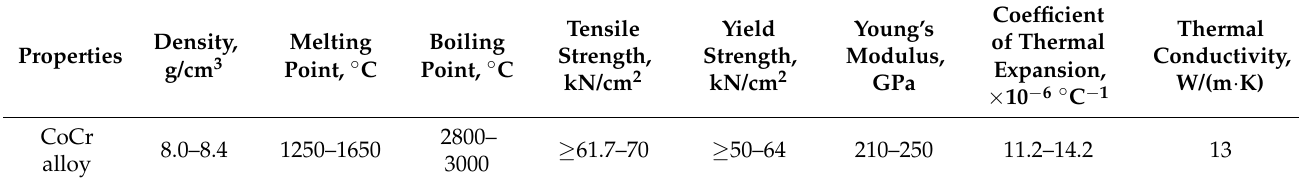
Table 2. Properties of the cobalt-chromium alloy (64–65% of Co, 29–30% of Cr).